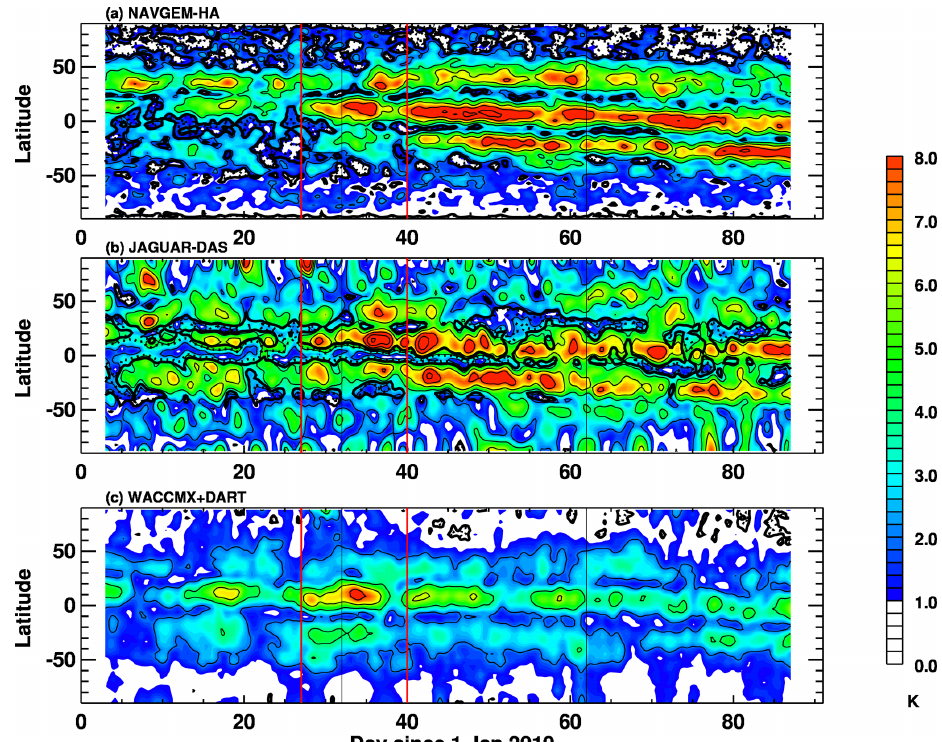
Figure 19. As in Fig. 18 but for the migrating semidiurnal wave 2